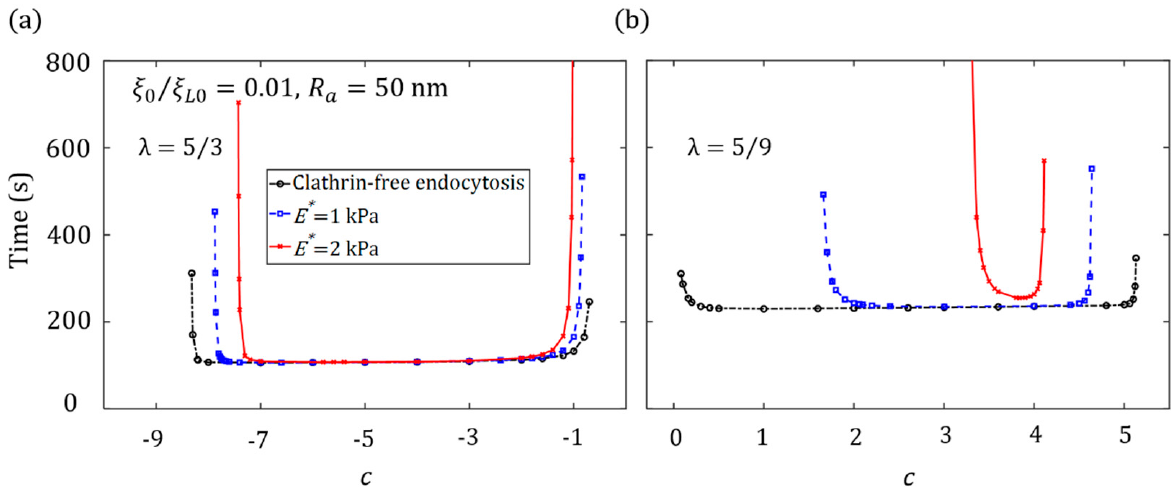
Figure 5. Wrapping time as a function of the degree of non-uniformity of ligand distribution, c , for membrane-mediated endocytosis and cytoskeleton-associated endocytosis pathways with E ∗ = 1 kPa, E ∗ = 2 kPa, during the cellular uptake of ( a ) oblate ellipsoid ( λ = 5/3) and ( b ) elongated NPs ( λ = 5/9) with ξ 0 = 0.01 ξ L 0 .